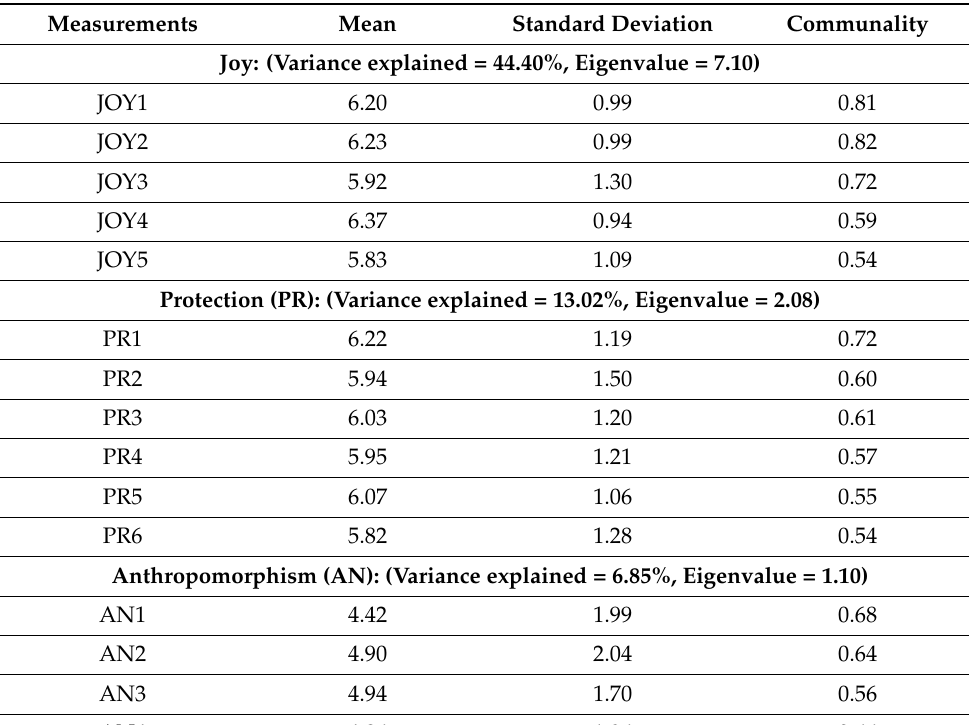
Table 3. The statistics of measurements: mean, standard deviation, and communality of joy, protec- tion, and anthropomorphism dimensions. Measurements